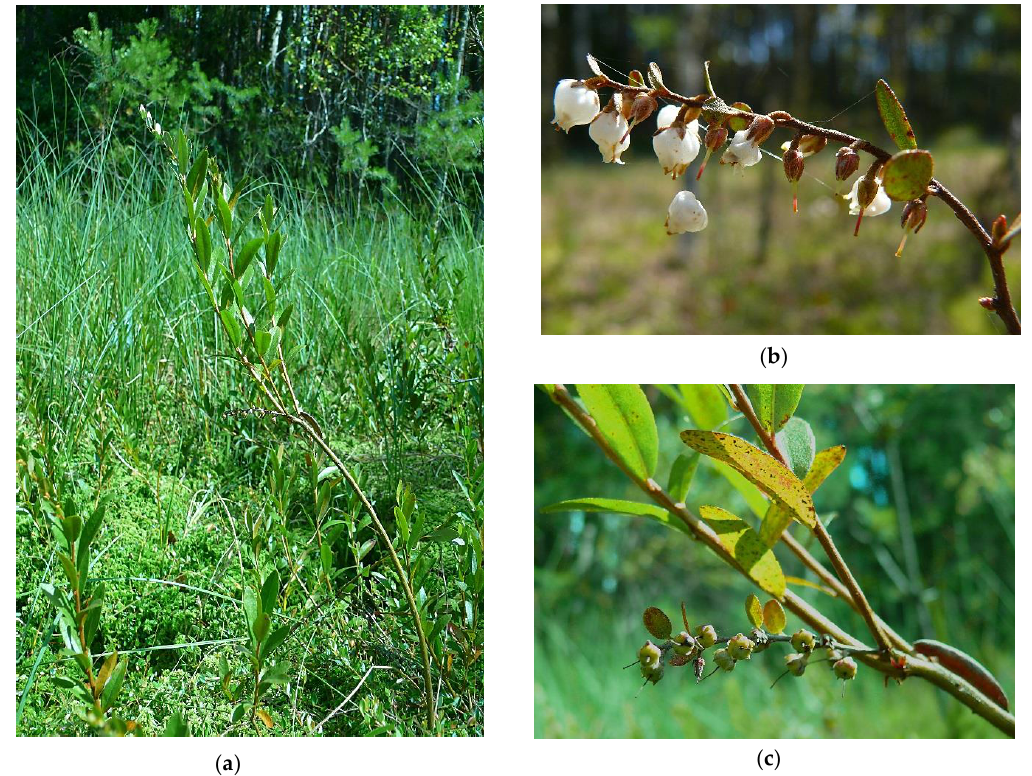
Figure 3. Chamaedaphne calyculata at the new site near Nerwik village. ( a ) General growth form, leaves and branches. ( b ) Flowers. ( c ) Unripe fruits.